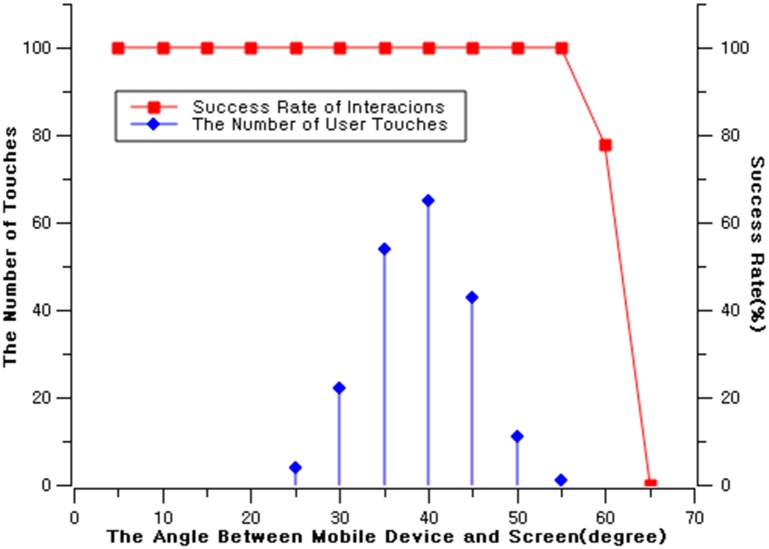
The angle measurement of mobile device and digital signage, and their success rate.